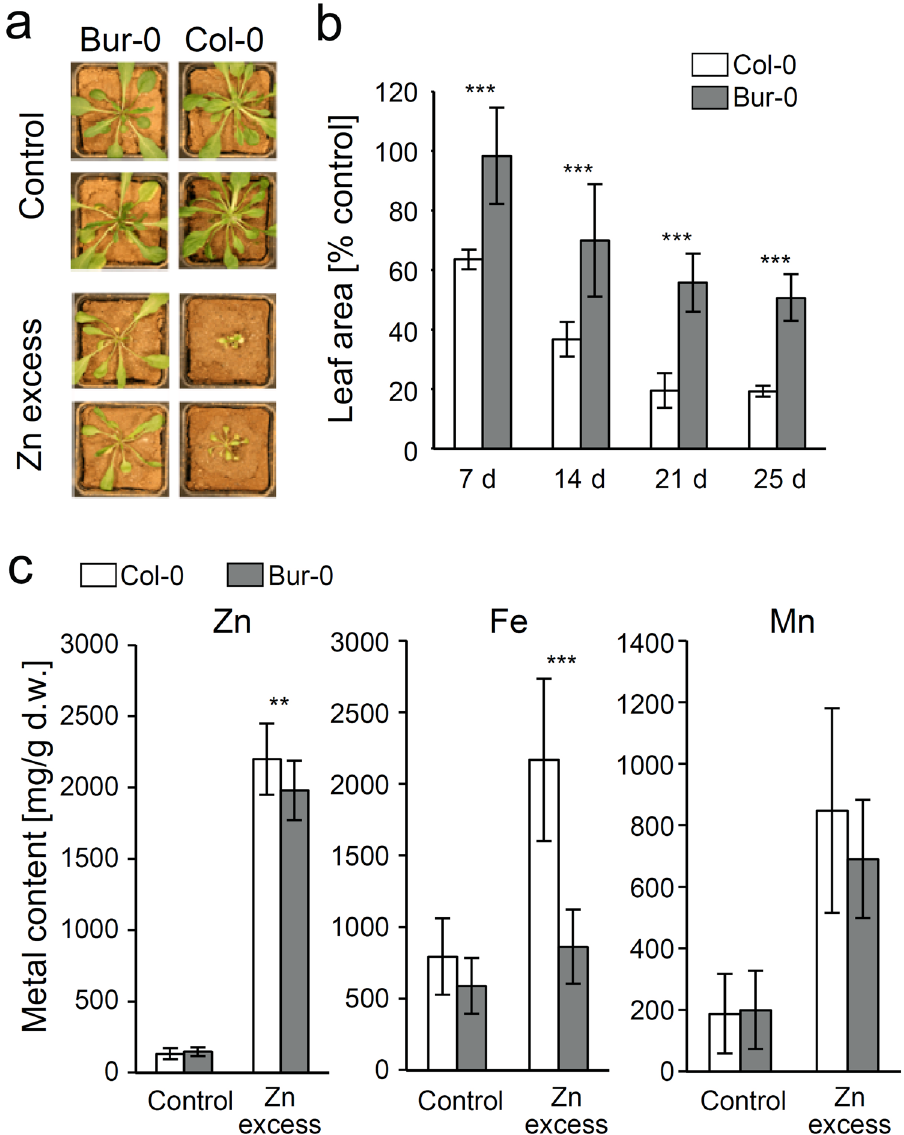
Figure 3. Growth and metal accumulation of accessions Bur-0 and Col-0 are differentially affected by an excess of Zn in the soil. Seven day old Col-0 and Bur-0 seedlings were transferred into soil with contrasting Zn supply. Pictures in ( a ) show plants after 25 d of growth in either control soil (400 mg ZnSO 4 added per kg soil, 52 µ g/g dry soil HCl-extractable Zn) or Zn excess soil (6400 mg ZnSO 4 added per kg soil, 756 µ g/g dry soil HCl- extractable Zn). ( b ): Growth of Col-0 (white bars) and Bur-0 (grey bars) was tracked by quantifying the leaf area of single plants over the course of the experiment. Relative growth for each individual on Zn excess soil was calculated as follows: Leaf area/mean leaf area control soil × 100. Data represent means ± SD of 3 independent experiments with each > 10 individual plants per accession and growth condition. ( c ): Metal content of leaves after 25 d of growth on the two contrasting soils. Data represent means ± SD of 3 independent experiments (n = 9, i.e. three sample pools per plant line and condition). Statistical analysis was performed by one-way ANOVA and subsequent Tukey test. The asterisks indicate significant differences between the accessions ( *** P < 0.001; ** P < 0.01), 95% confidence interval. Percentage values were square root transformed prior to statistical